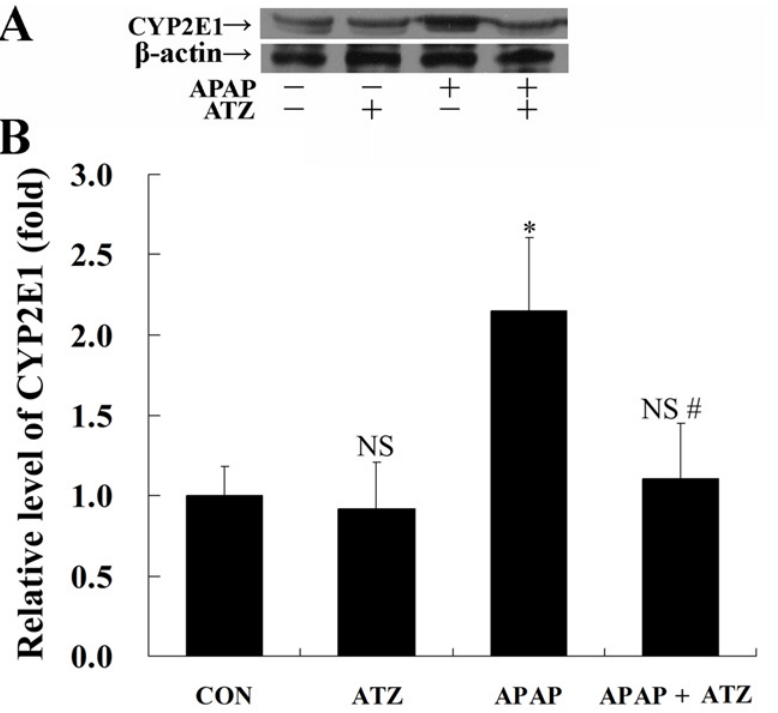
Fig 7. Pretreatment with ATZ decreased the level of CYP2E1 in APAP exposed mice. Mice were treated with vehicle or ATZ (500 mg/kg) at 30 min before APAP exposure. Liver samples were harvested at 8 h after APAP exposure. The levels of CYP2E1 were determined by Western blot analysis. (A) The bands of CYP2E1 and β -actin were indicated by arrows. (B) Western blots were scanned by densitometry and data presented as relative intensity units. Data were expressed as mean ± SD, n = 8. NS P > 0.05, * P < 0.05, as compared with the CON group; # P < 0.05, as compared with the APAP